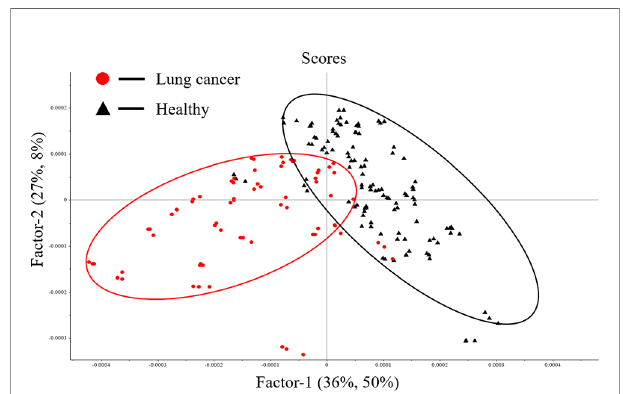
FIGURE 4 | Score plot of Factor-1 and Factor-2.